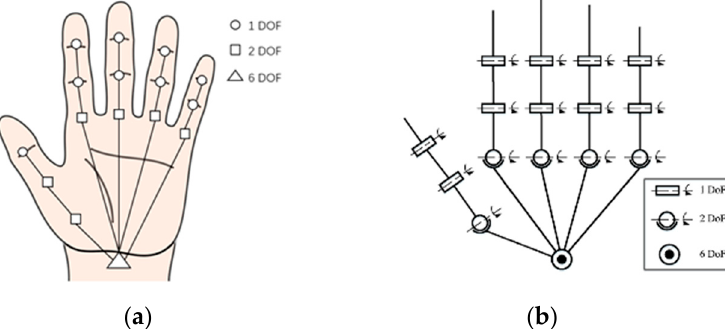
Figure 2. Common kinematic model applied for pose estimation. ( a ) A kinematic hand model with 27 degrees of freedom (DoF) [15]. ( b ) Another kinematic model with 26 DoF [14].